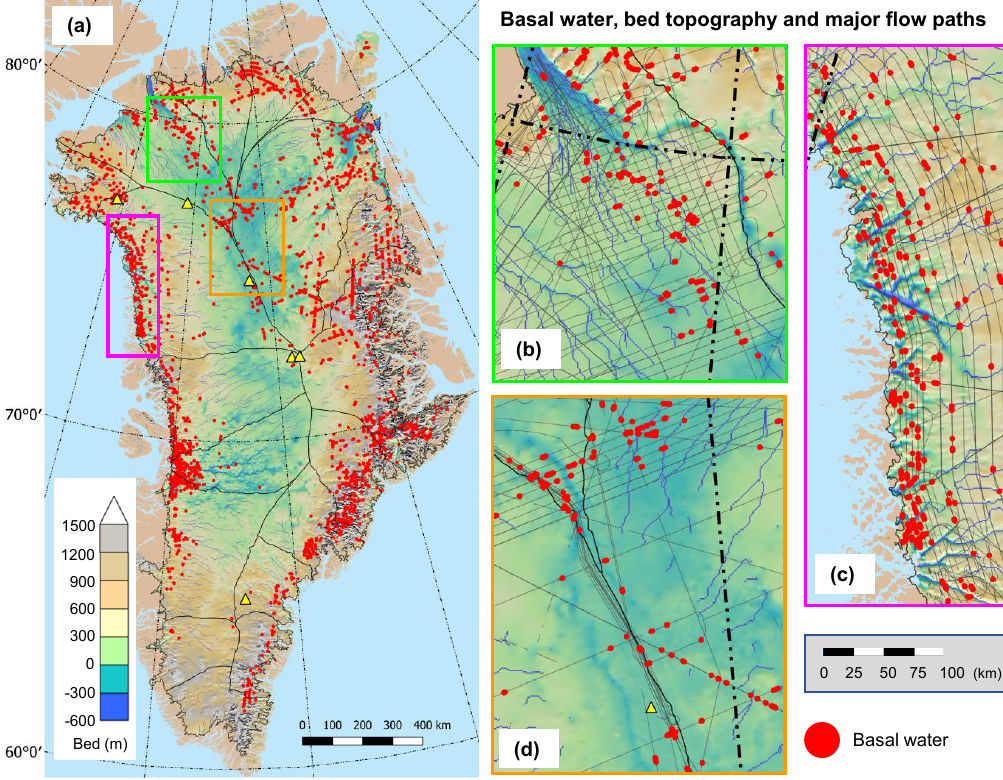
Figure 9. Comparison between basal water distribution, bed topography (Morlighem et al., 2017) and major subglacial flow paths (blue lines). (a) Ice-sheet scale. (b) Petermann catchment. (c) North-western margins. (d) North-central ice sheet. To improve clarity the radar flight tracks are removed from (a) and a hillshade is applied to the bed topography. The zoomed-in panels are all have the same scale ( × 4 the resolution of a